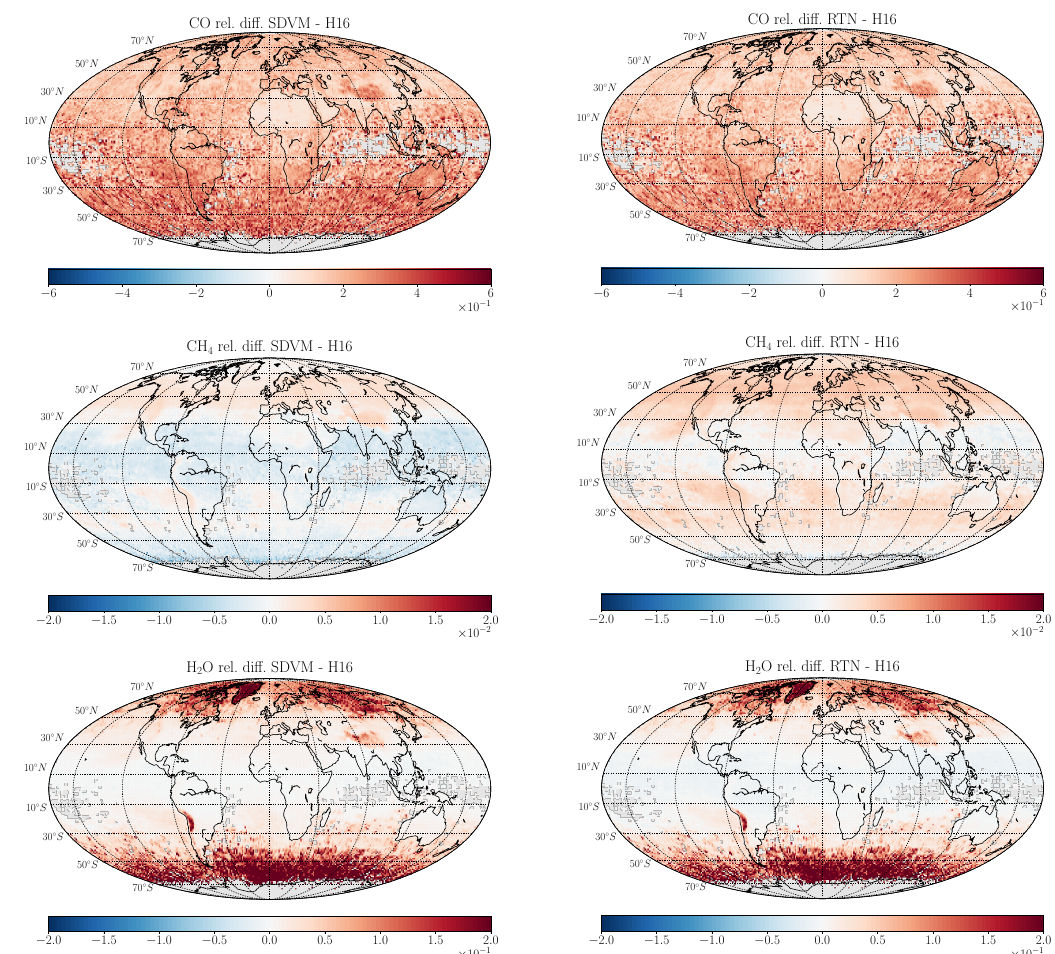
Figure A1. Spatial distribution of differences in the retrieved profile scaling factors on a 1 April–June 2004. Left column: SDVM-H16. Right column: RTN-H16 relative